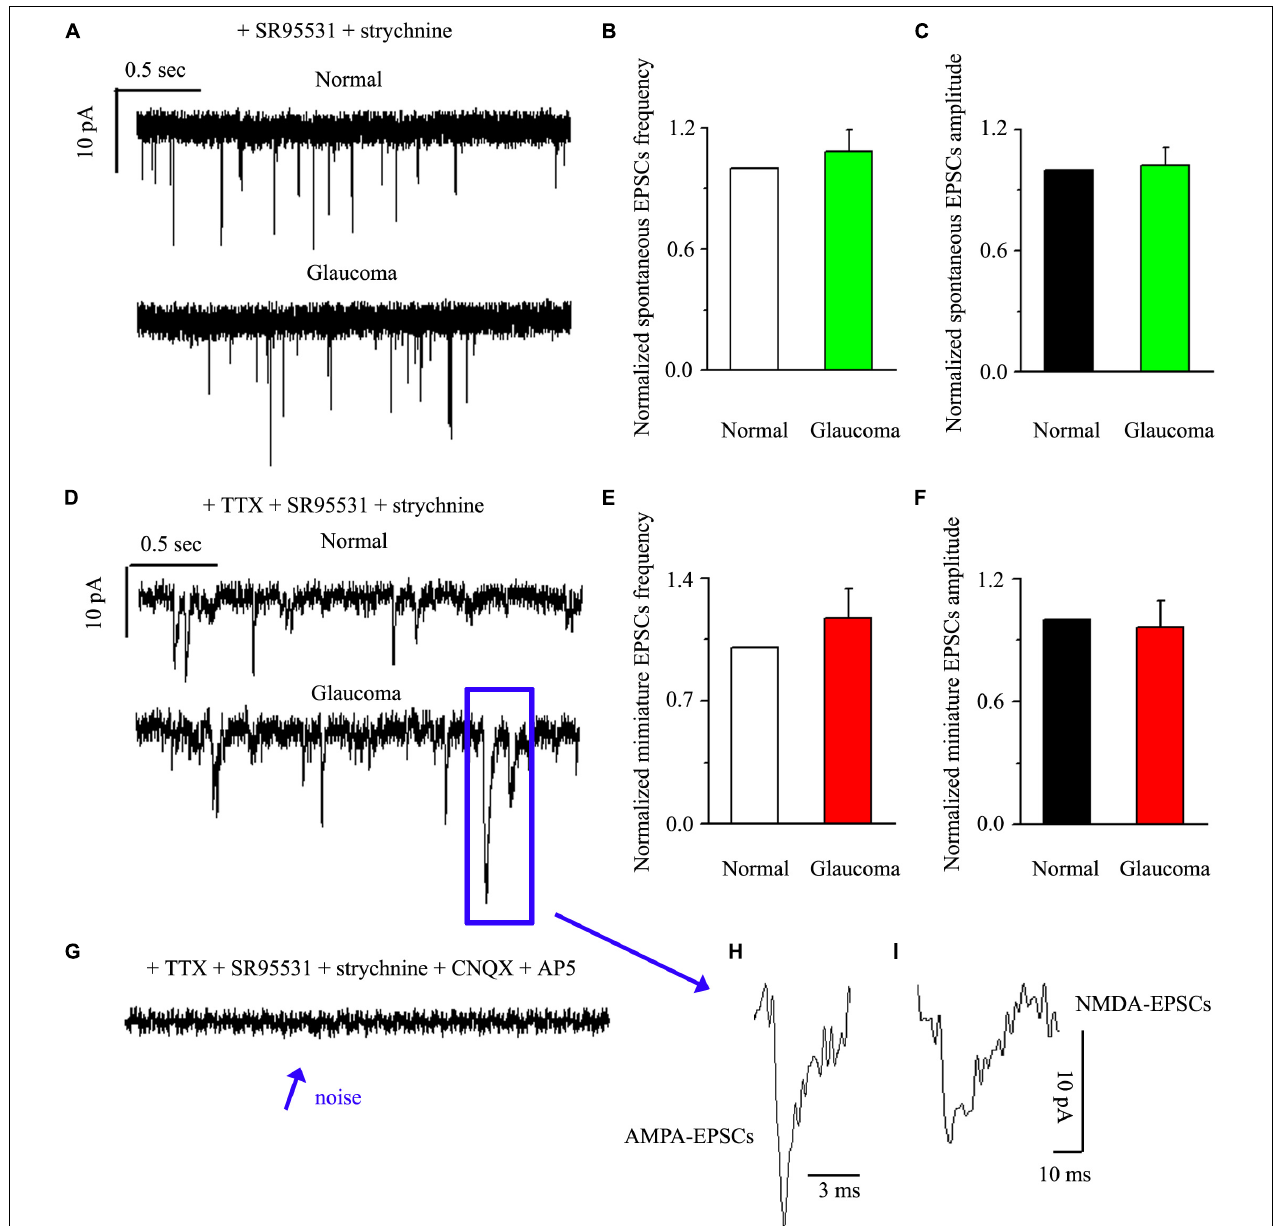
FIGURE 3 | Ocular hypertension did not significantly change the frequency or amplitude of sEPSCs and mEPSCs in RGCs. (A) Top: representative recording from a normal rat experiment. Vertical scale bar: 10 pA; horizontal scale bar: 0.5 s. Bottom: representative recording from a glaucomatous rat experiment. Vertical scale bar: 10 pA; horizontal scale bar: 0.5 s. Summarized data for the frequency (B) and amplitude (C) of sEPSCs between normal and glaucomatous RGCs ( n = 7). (D) Top: representative recording from a normal rat experiment. Vertical scale bar: 10 pA; horizontal scale bar: 0.5 s. Bottom: representative recording from a glaucomatous rat experiment. Vertical scale bar: 10 pA; horizontal scale bar: 0.5 s. Summarized data for the frequency (E) and amplitude (F) of mEPSCs between normal and glaucomatous RGCs ( n = 9). (G) The signal and noise can be identified under recording conditions in which TTX + SR95531 + strychnine + CNQX +AP5 are administered. (H) The enlarged AMPA component EPSCs in the blue box of (D) ; horizontal scale bar: 3 ms. (I) The enlarged NMDA component EPSCs in the blue box of (D) ; vertical scale bar: 10 pA; horizontal scale bar: 10 ms. The results in (B,C,E,F) are expressed as the mean ± standard error.